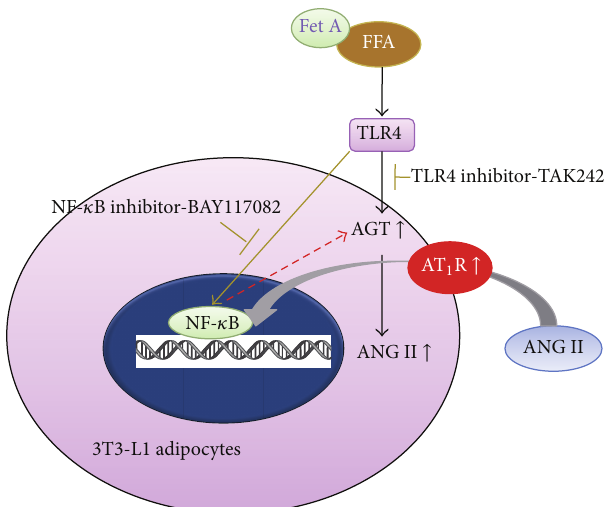
Figure 8: Mechanism of RAS activation induced by FFA (PA) in 3T3-L1